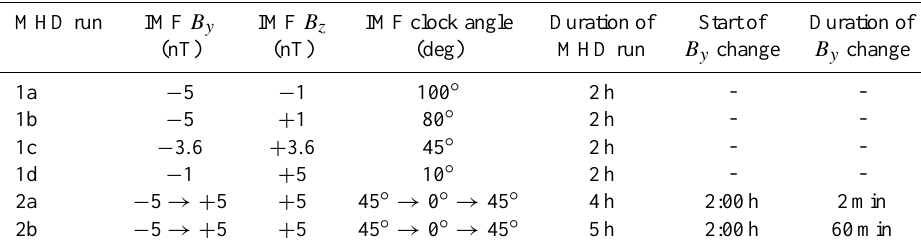
Table 1. The GUMICS-4 simulation